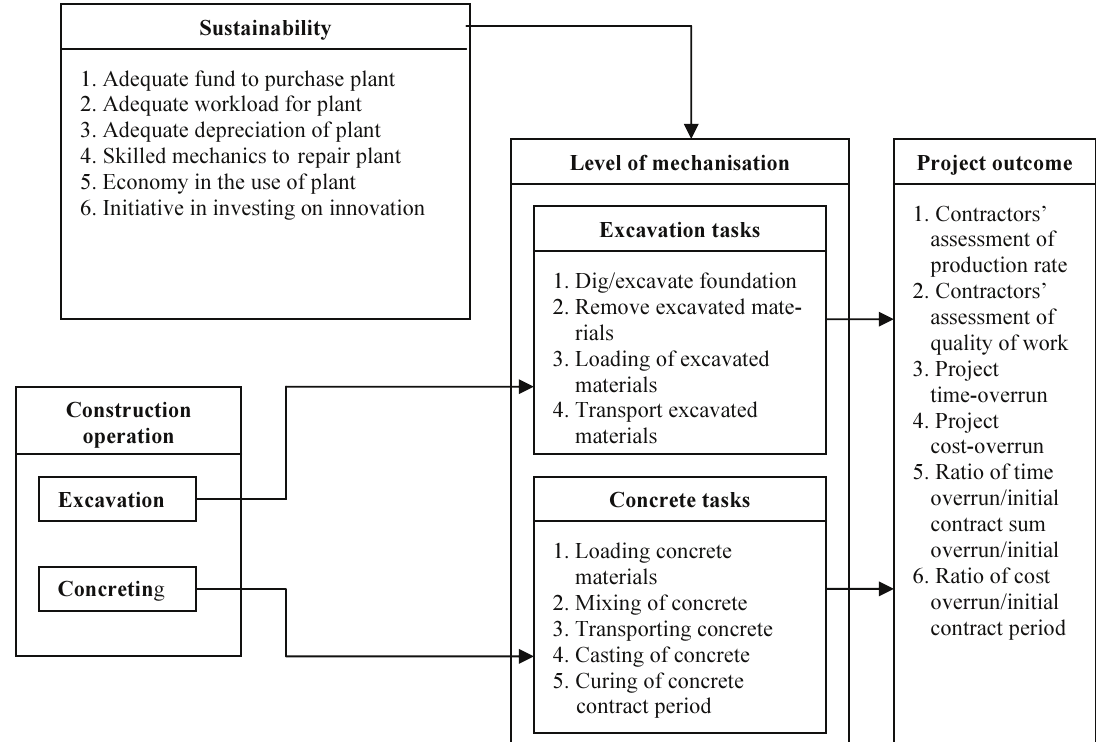
Fig. 1. Conceptual framework for evaluating the correlation between the level of mechanisation and project outcome